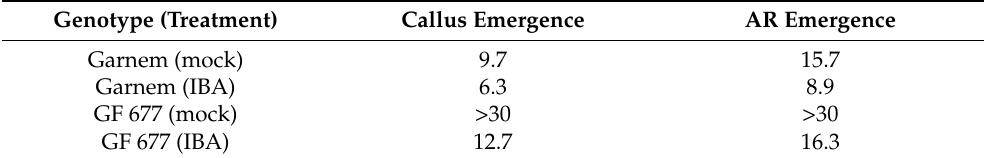
Table 2. RR50 values (expressed in dae) obtained for callus and AR emergence from E1 and E2. Genotype (Treatment) Callus Emergence AR Emergence Garnem (mock)